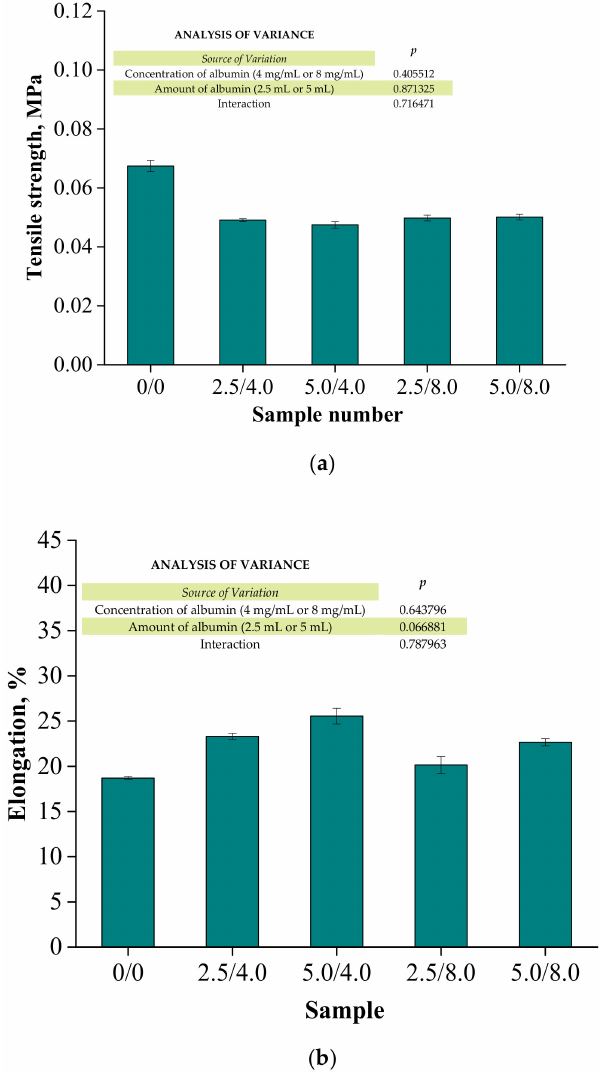
Figure 14. Results of the mechanical evaluation of tested materials: tensile strength ( a ) and percentage elongation ( b ) (n—number of repetitions, n = 3; p indicates the statistical significance calculated using the two-way analysis of variance